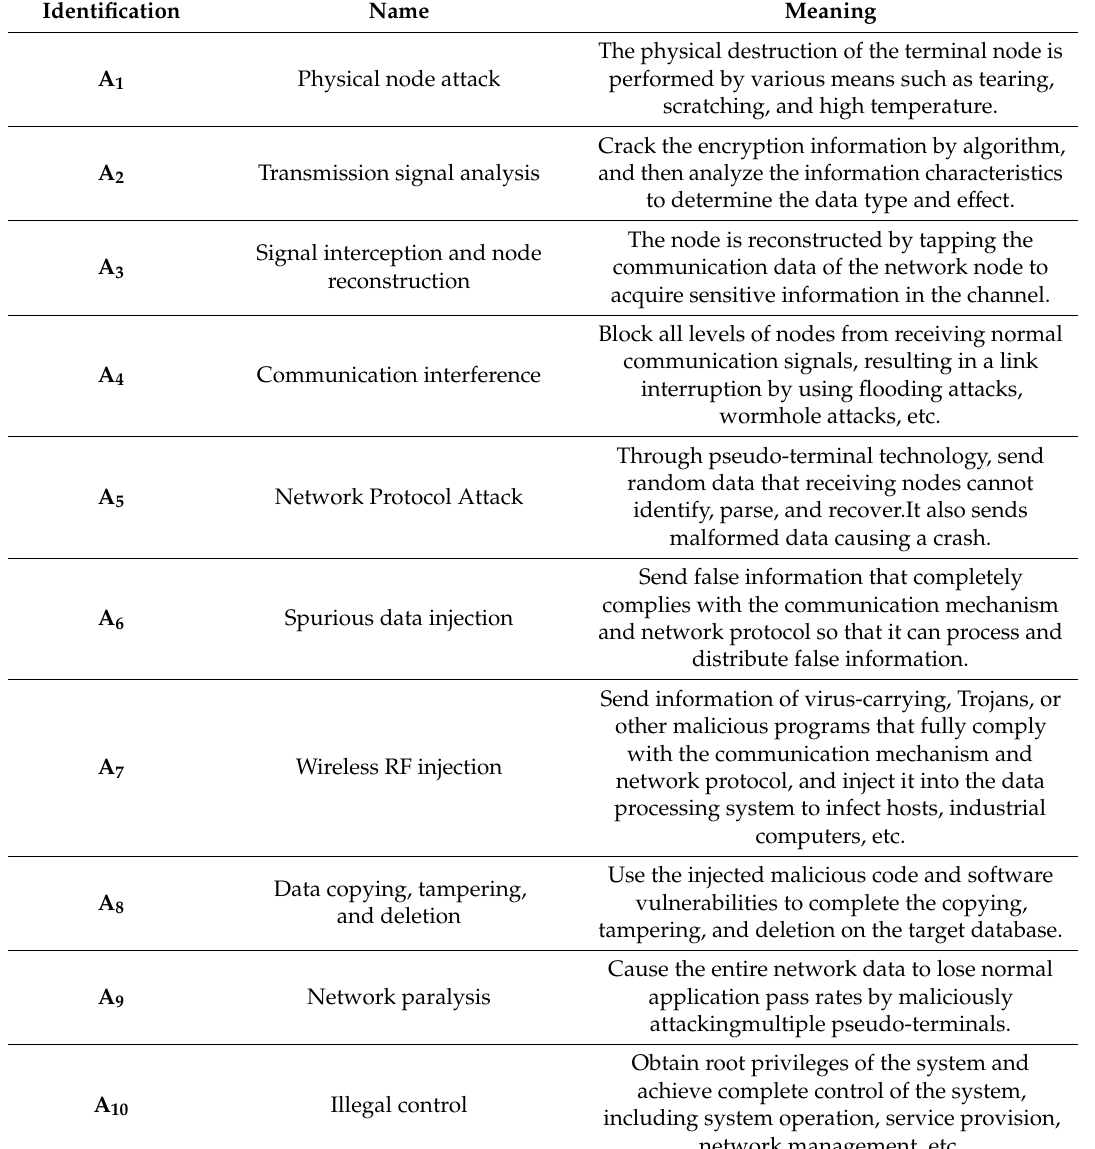
Table 3. Names and meanings of attacking node